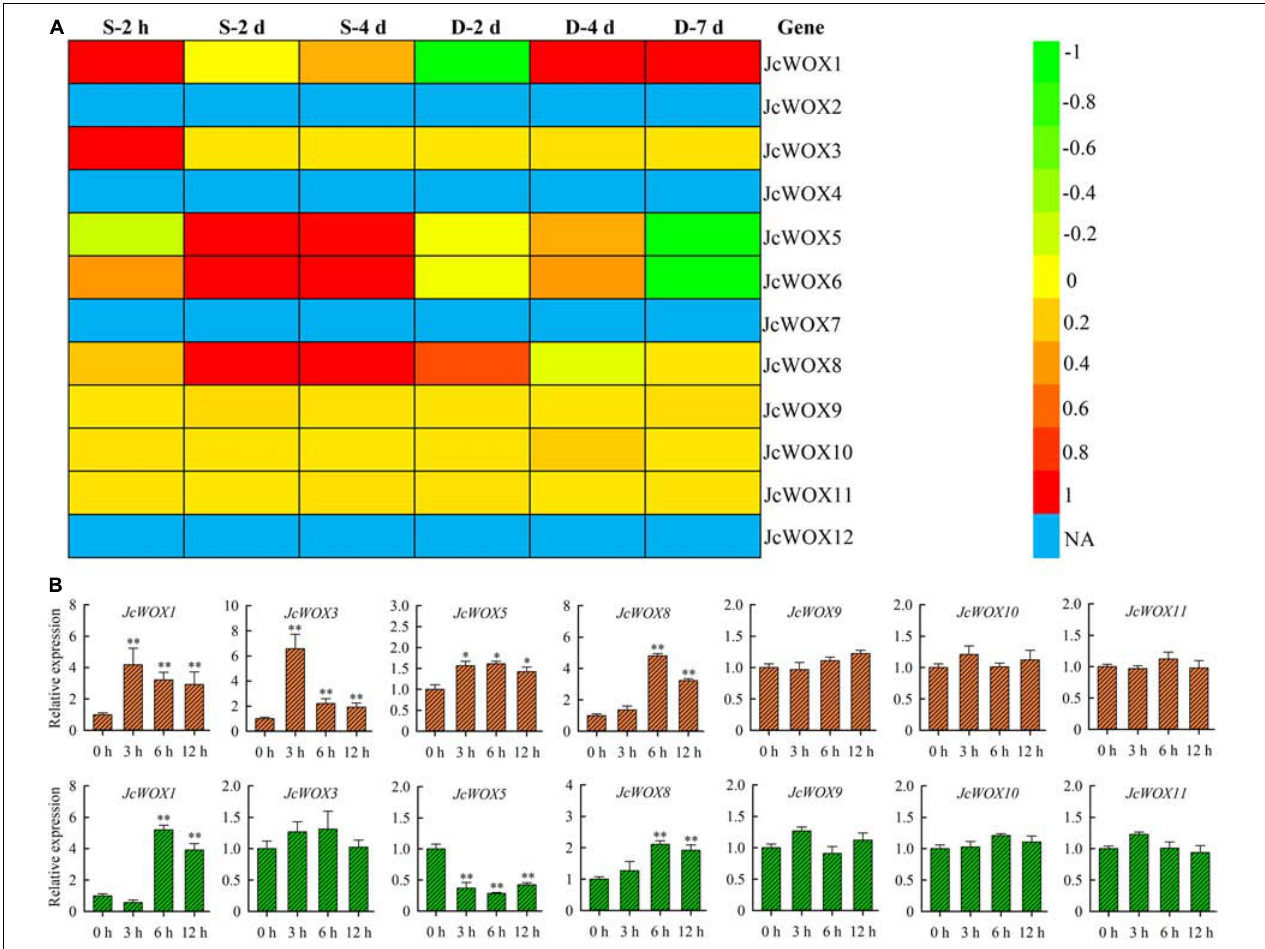
FIGURE 5 | The transcription level of the JcWOX gene under drought and salt stress. (A) Roots of expression of the 12 JcWOX genes in physic nut exposed to drought (D) and salinity (S) stresses: log 2 ratios of signals from treated versus control leaves are presented as a heat map based on transcriptomic data, with the color scale shown on the right. NA, not available. (B) Detection of JcWOX genes expression level by qRT-PCR in roots. The experiment contains three biological replicates, and asterisks above the bars indicate significant differences from wild-type controls at p < 0.01 (**) or 0.01 < p < 0.05 (*).